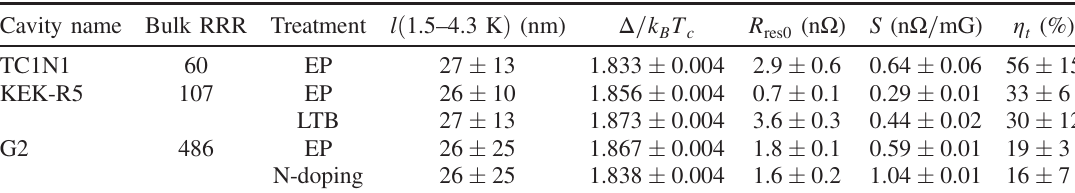
TABLE II. S , R and fraction of the applied field being trapped, η res 0 cooldown conditions and weighted average values of mean free path and Δ =k ð T Þ between 1.5 – 4.3 K for each cavity. sets of R s